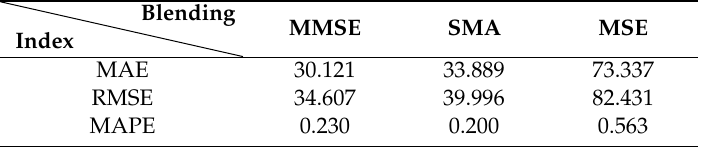
Table 5. Evaluation of blending technique using maximum ensemble data.